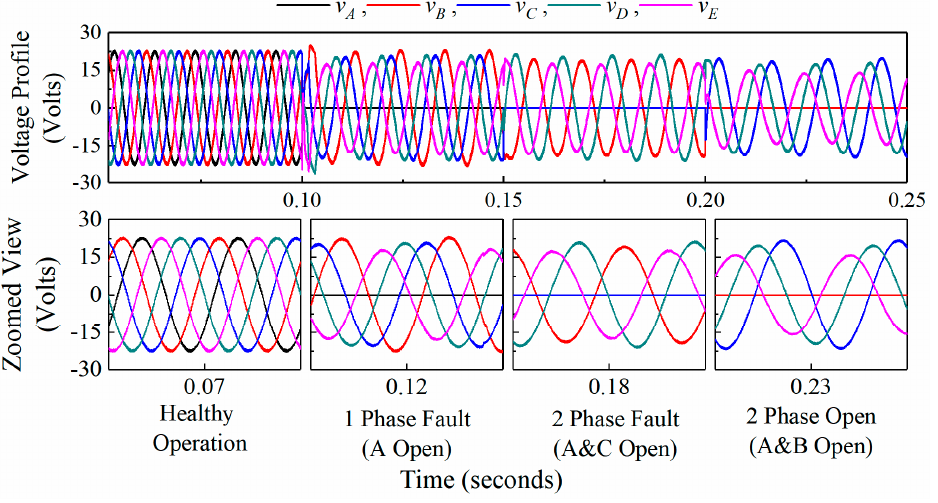
Figure 14. Phase voltage profile in case of healthy operation, one-and two-phase fault operations.